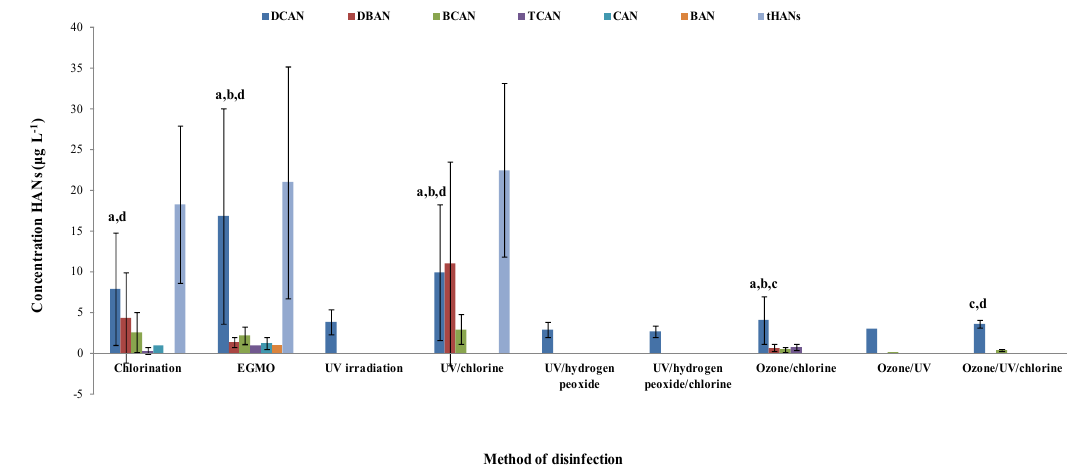
Figure 3. Mean and standard deviation of HANs with different methods of disinfection. Note: “ a ” shows that chlorination is not significantly different from EGMO, UV/chlorine and ozone/chlorine; “ b ” shows that EGMO and UV/chlorine are significantly different from ozone/chlorine; “ c ” shows that ozone/chlorine and ozone/UV/chlorine are not significantly different from each other; “ d ” shows that ozone/UV/chlorine is significantly different from chlorination, EGMO and UV/chlorine at α = 0.05 ( p < 0.05). Statistical analysis to compare the means in case of UV irradiation, UV/hydrogen peroxide, UV/hydrogen peroxide/chlorine and ozone/UV was not carried out because of fewer data points.